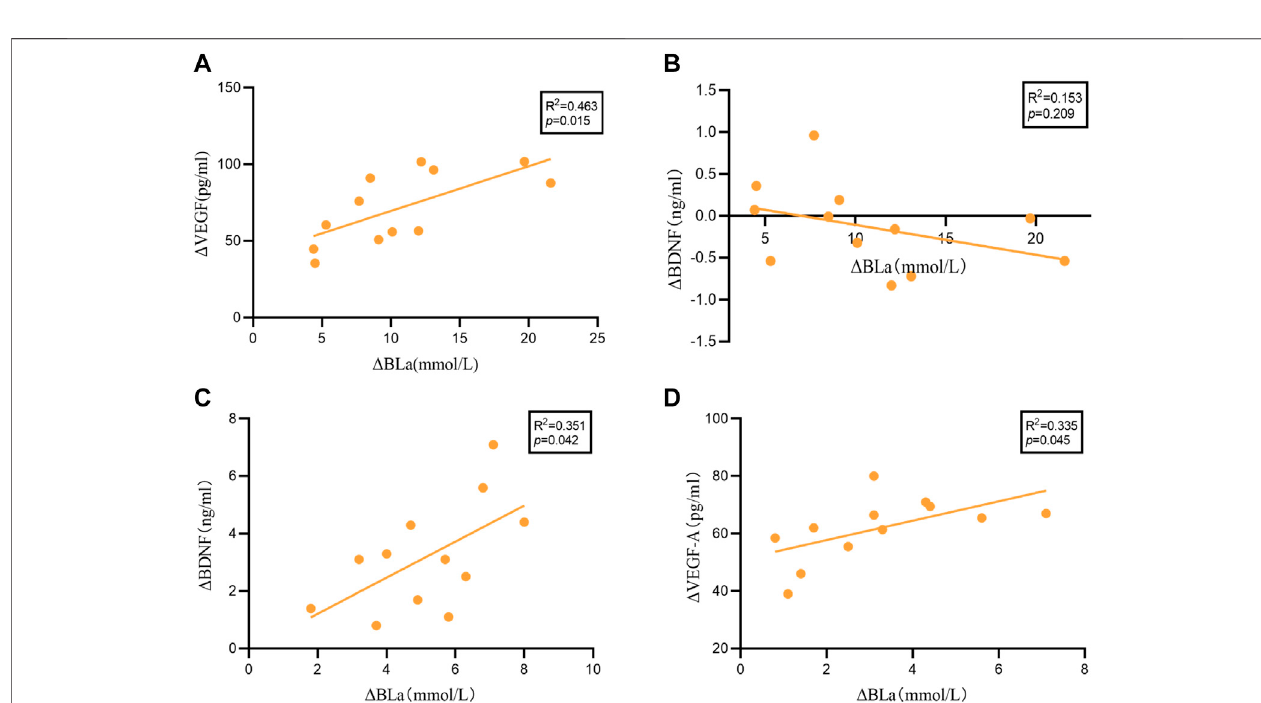
FIGURE 3 | The results of the linear regression analysis. (A) : Δ BLa and Δ VEGF-A in 30 minutes HIIT intervention. (B) : Δ BLa and Δ BDNF in 30 minutes HIIT intervention. (C) : Δ BLa and Δ VEGF-A in 20 minutes HIIT intervention. (D) : Δ BLa and Δ BDNF in 20 minutes HIIT intervention.